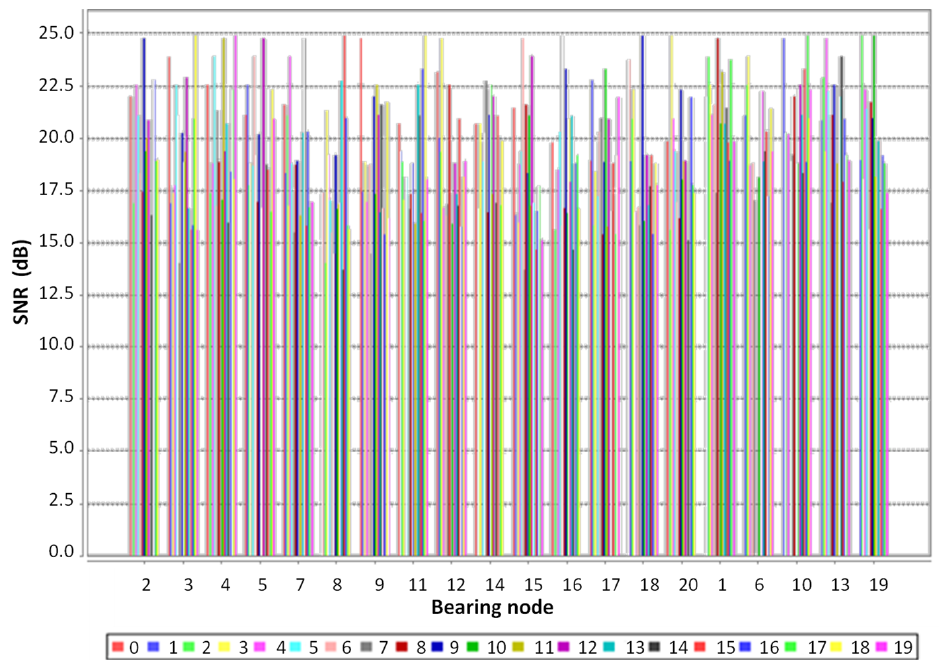
Figure 11. Average signal-to-noise ratio (SNR) estimation for the network of 20 nodes. Figure 12 gives an estimate of the average SNR for some of the network nodes